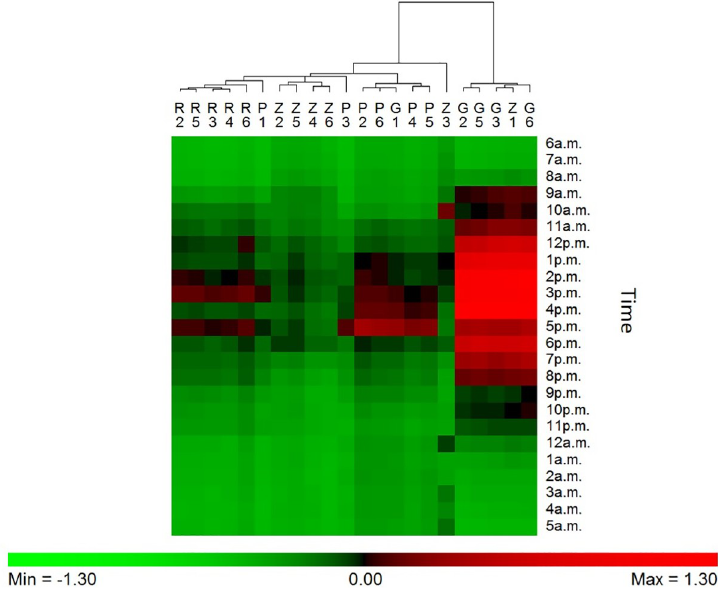
Fig 2. Hygroregulation observed (ratio (RHi-RHe)/RHe) in the central brood frame (iButton B)) of each of the 6 hives during a 24h-period in the summer, from 6 a.m. (July 21, 2016) to 5 a.m. of the next day (July 22, 2016), in